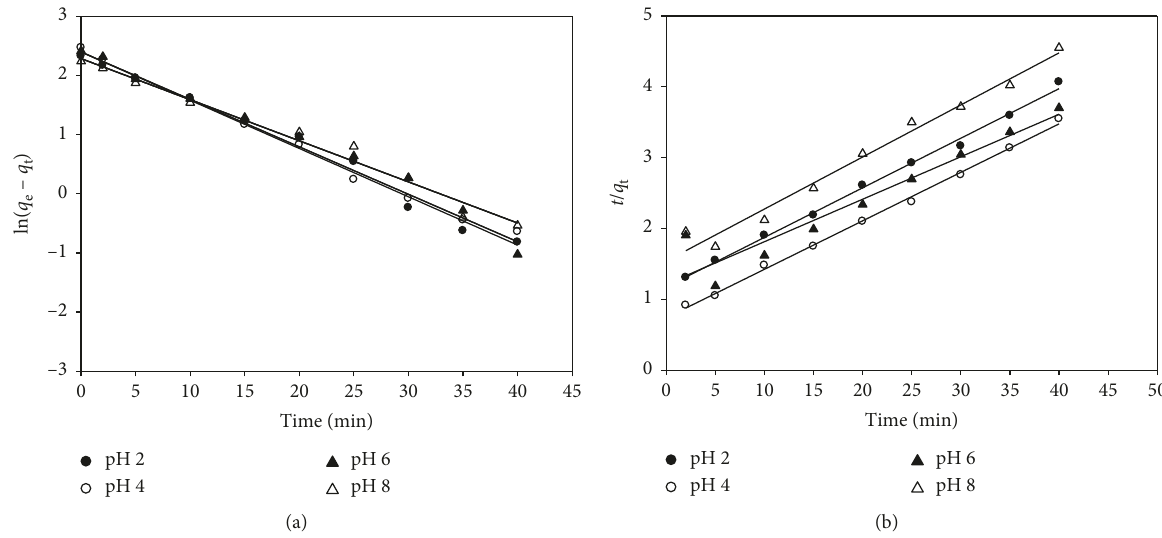
Figure 8: First-order (a) and second-order kinetics (b) modeling of Cr(VI) biosorption on Grewia spp. biopolymer. Biosorbent dose: 0.8g/L, T 25 2 ° C. (cid:31) ± Table 1: Kinetics parameters for Cr(VI) biosorption on Grewia spp. biopolymer. First-order Initial pH of the solution